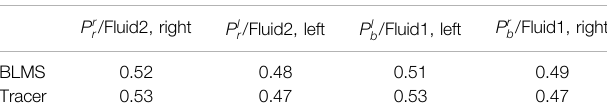
r /Fluid2, left P